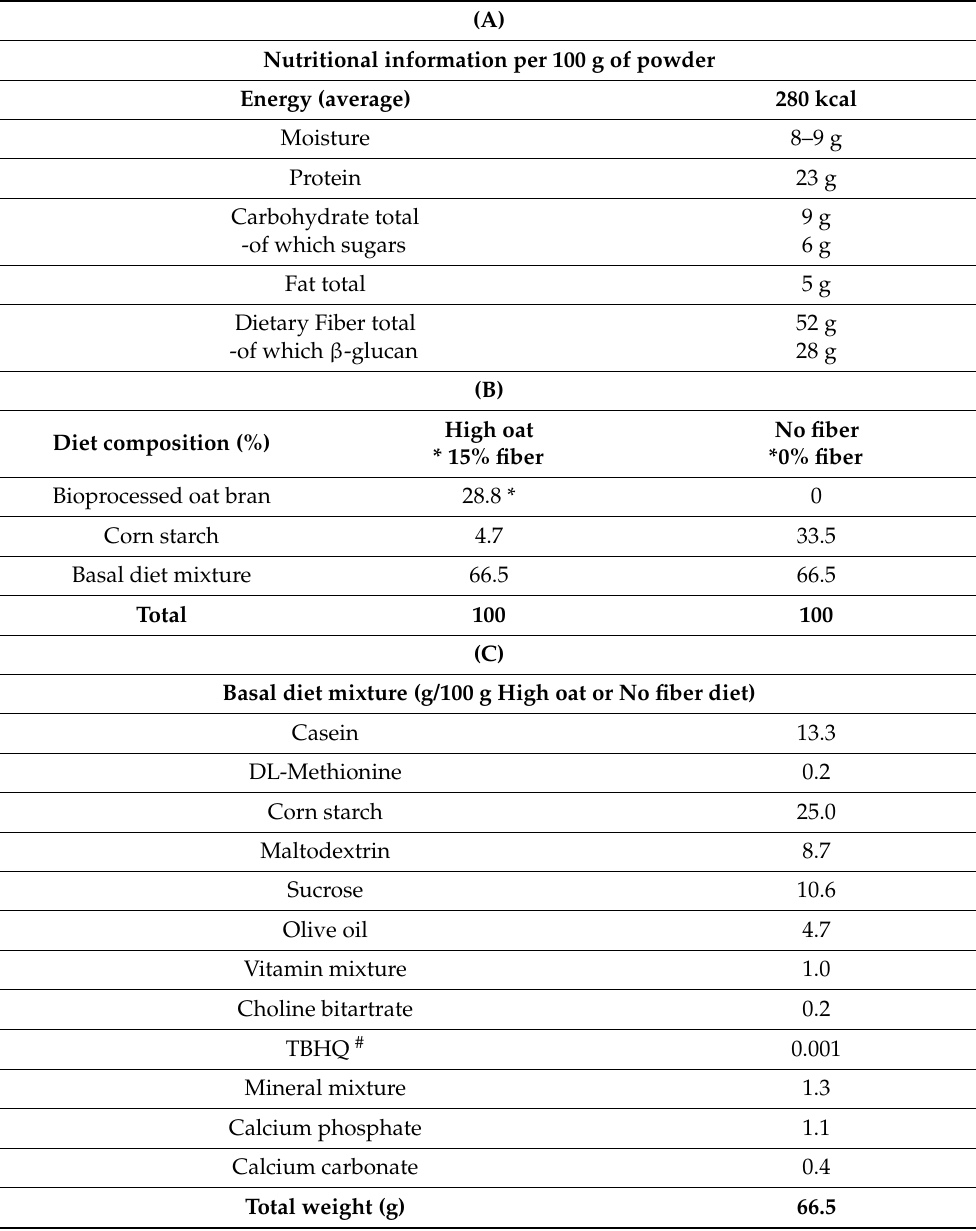
Table 1. Diets. (A) Bioprocessed oat bran specifications. (B) Diet compositions. (C) Ingredients basal diet mixture. * Dry-weight basis. # Tertiary